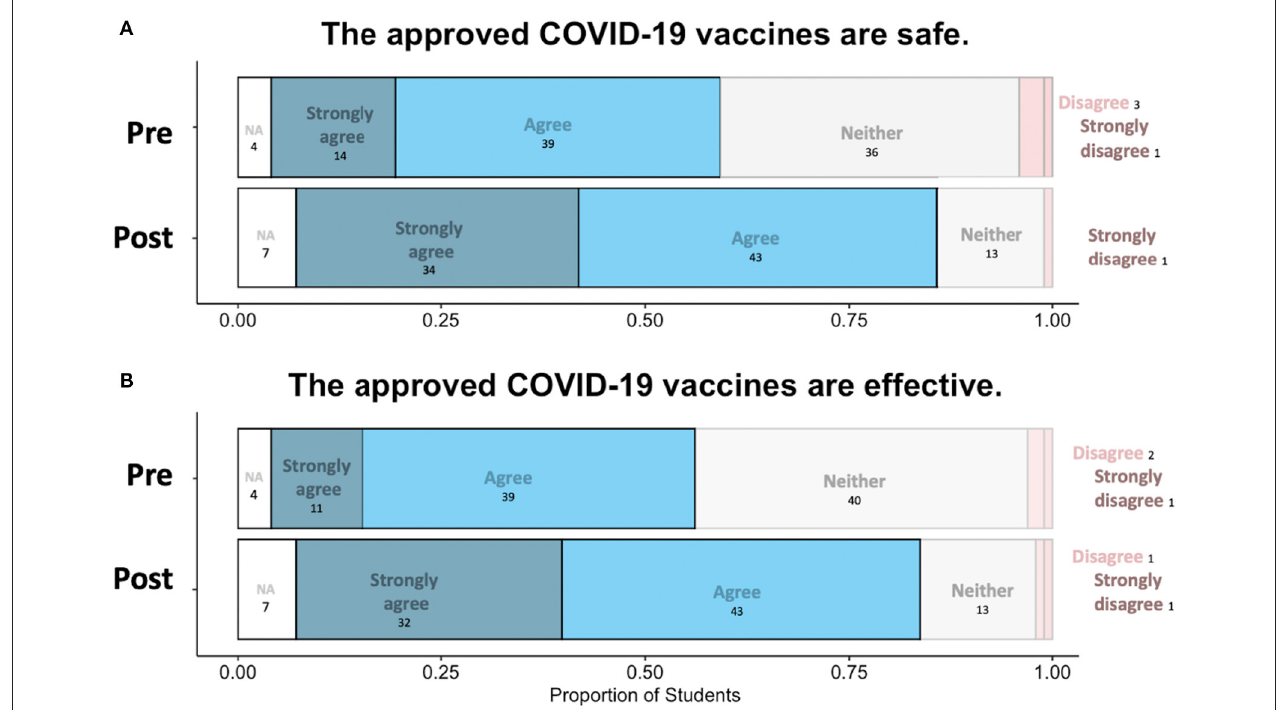
FIGURE 1 | Pre and post agreement to COVID-19 vaccine safety (A) and efficacy (B) . Pre indicates prior to the module and post indicates perception following module completion. Student agreement ranges from strongly agree (left most and dark blue) to strongly disagree (right most and darker pink). Students responded “NA” if they did not want to answer based on having already been vaccinated. The proportion of total students is on the X axis, where N =